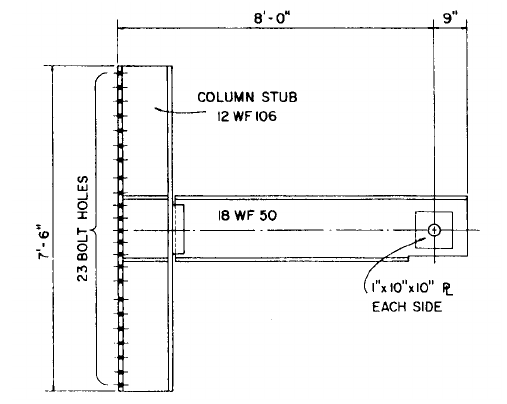
Fig. 14. Test specimens